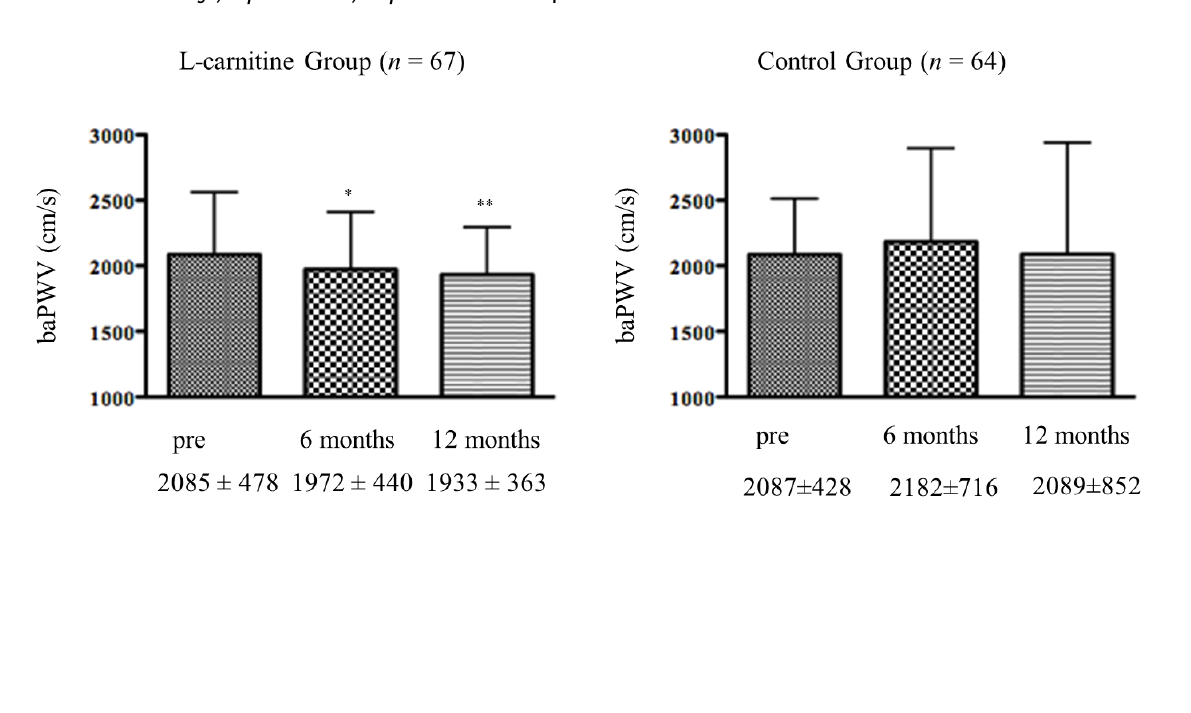
Figure 2. Changes in baPWV following L -carnitine treatment. baPWV, brachial-ankle pulse wave velocity; * p < 0.05, ** p < 0.001 vs. pre